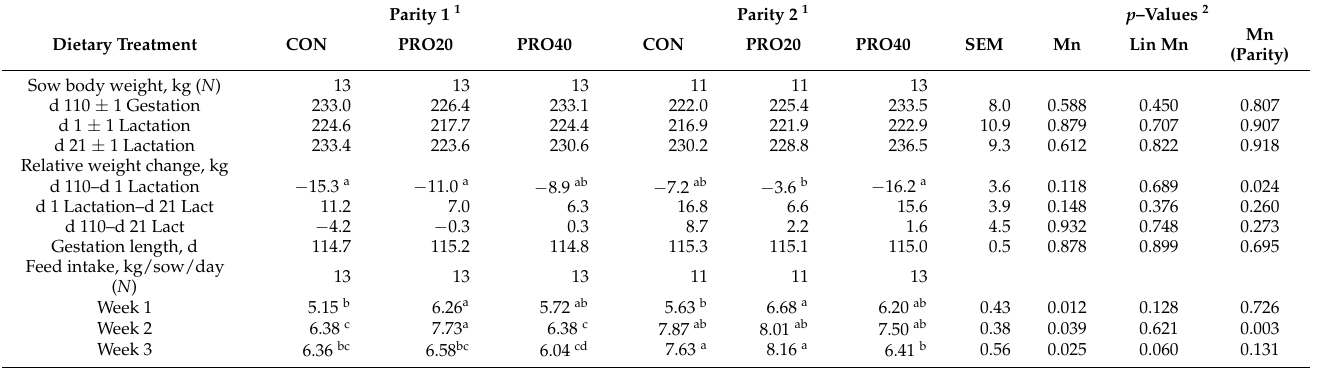
Table 2. The effect of supplemental dietary Mn (0, 20, 40 ppm) on the reproductive performance of sows over two